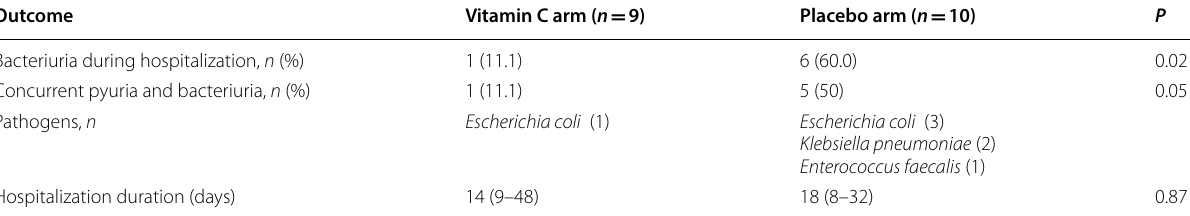
Table 2 Outcomes comparison between study arms